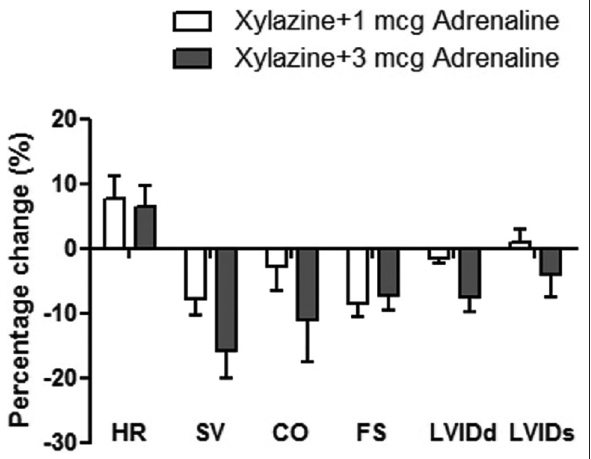
Figure-3: The comparisons of percentage change of cardiac parameters at baseline (T0) and at T100; HR=Heart rate, SV=Stroke volume, CO=Cardiac output, FS=Fractional shortening, LVIDd=Left ventricle diameter during diastole, and LVIDs=Left ventricle diameter during systole; error bars indicate standard error of the mean.